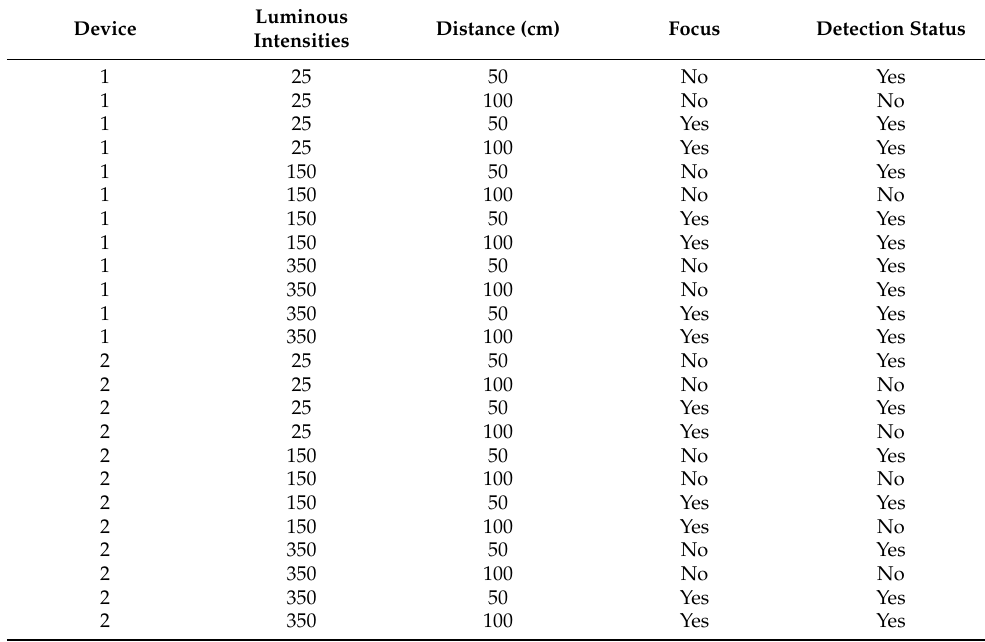
Table 4. AR-based object detection experiments using different devices, luminous intensities, dis- tances between mobile camera and multimeter, and camera’s